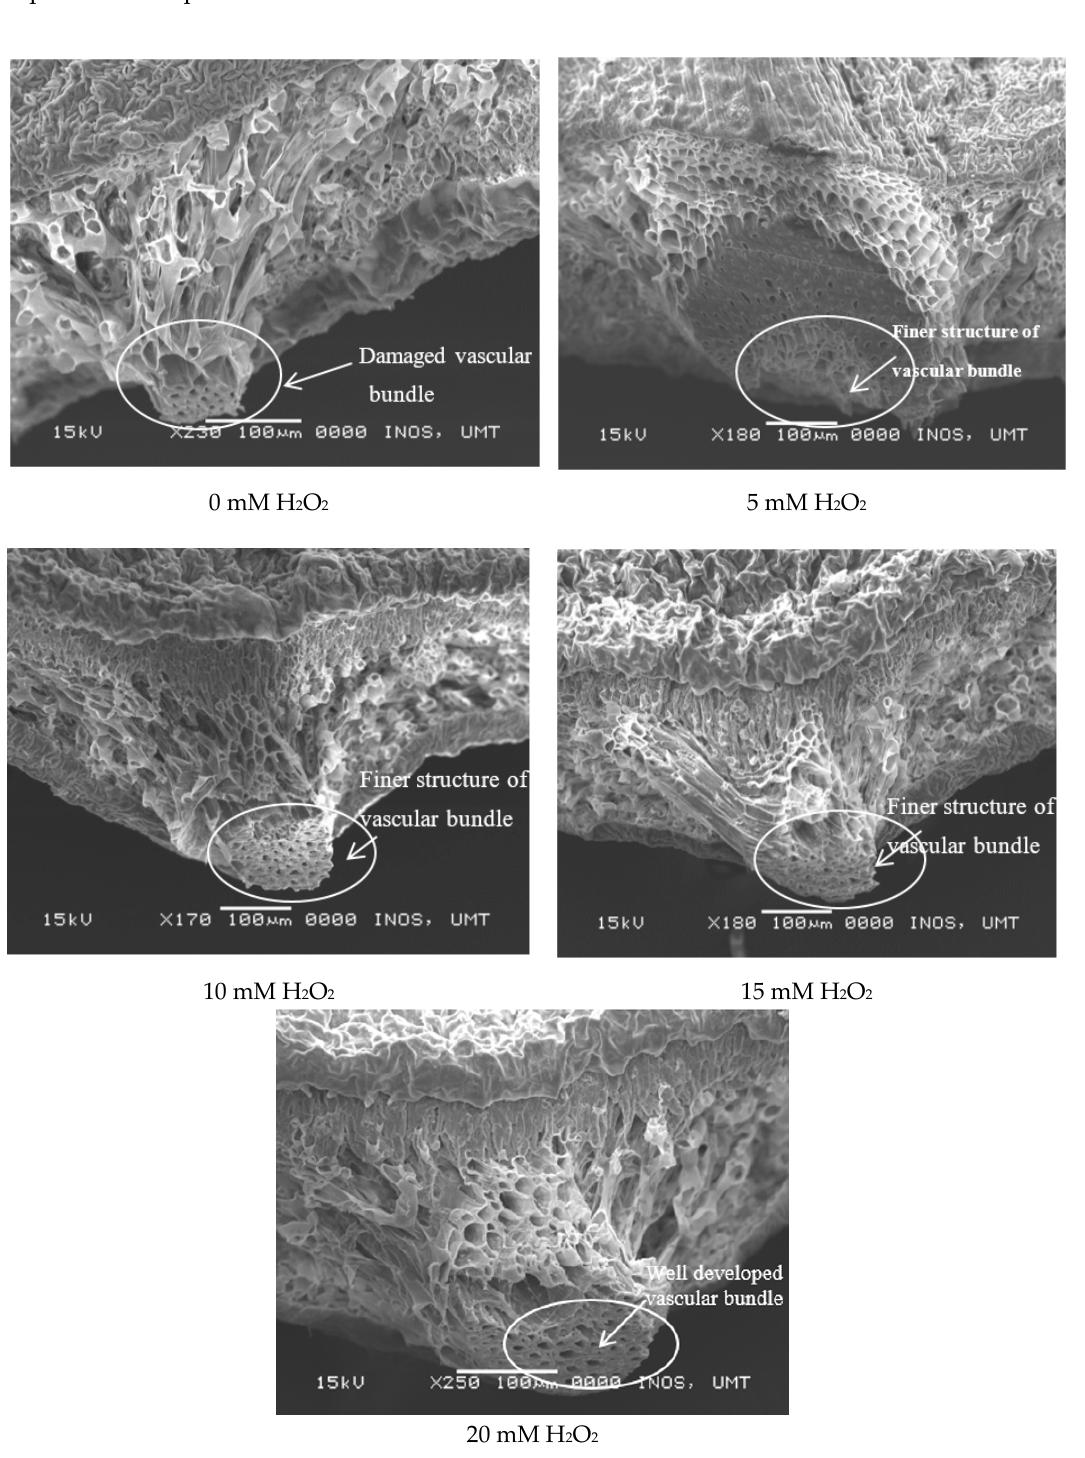
Figure 6. SEM photographs of vascular bundle of leaf of treated and untreated Ficus deltoidea var. deltoidea plant.